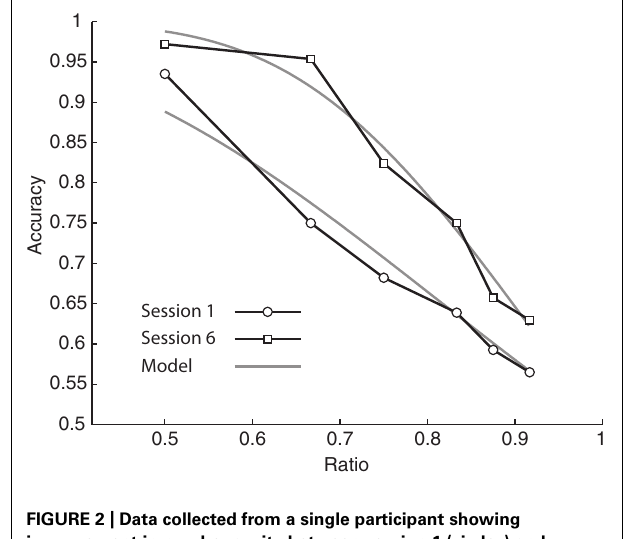
FIGURE 2 | Data collected from a single participant showing improvement in number acuity between session 1 (circles) and session 6 (squares). Gray lines show model predictions for the best fit w for session 1 ( w = 0.37) and session 6 ( w = 0.20).The improvement in w was typical of our